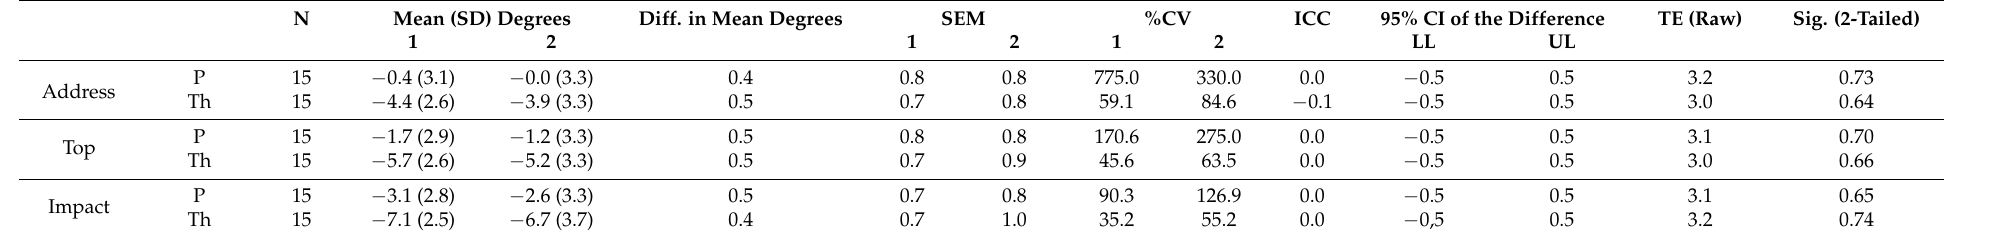
Table 4. Reliability of the Polhemus Liberty system for segment and joint angular kinematics in the longitudinal